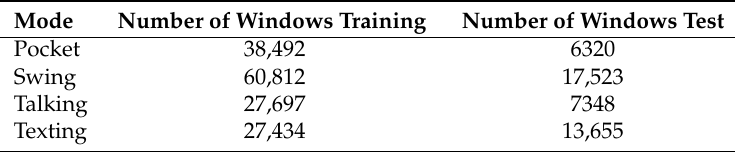
Table 1. Number of windows used for each smartphone